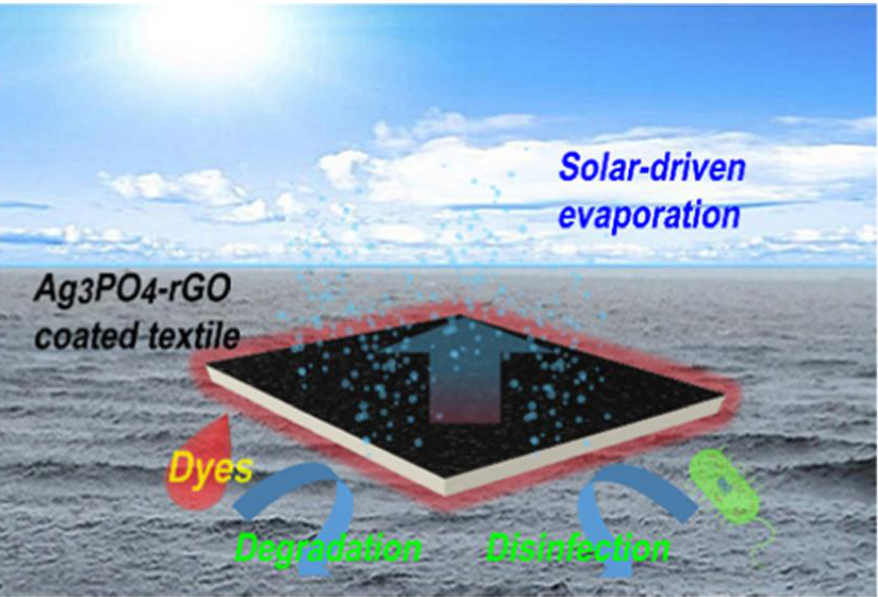
Figure 7. Application of reduced graphene oxide derived Ag 3 PO 4 -rGO coated textile in production of clean water by the process of solar evaporation, decontamination and disinfection. Reprinted with permission from Ref. [114].